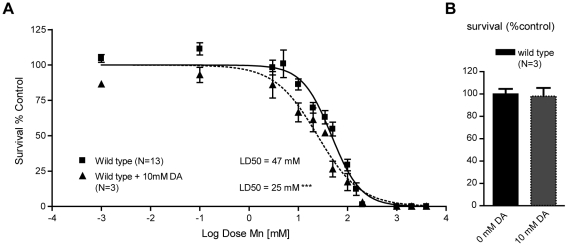
Sub-lethal dopamine pre-treatment sensitizes wild-type worms to Mn exposure.(A) Pre-treatment with 10 mM dopamine renders wild-type worms hypersensitive (p<0.001) to subsequent MnCl2 exposure, bringing the LD50 from 47 mM to 25 mM. (B) 10 mM L1 acute treatment does not affect wild-type worm survival at 24 h.